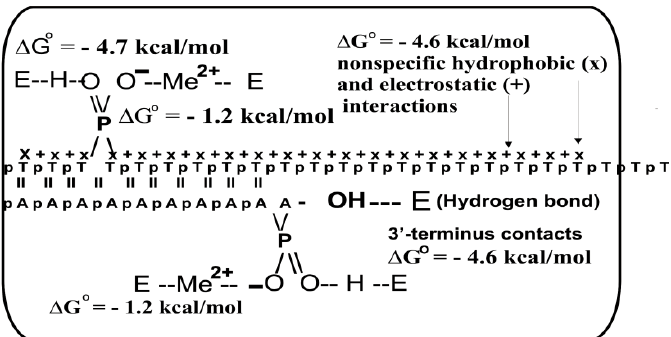
Figure 2. A thermodynamic model for the interaction of human DNA polymerase α with d(pT) 20 × d(pA) 10 [20,21]. It can be seen that the globule of DNA polymerase covers 20 nucleotide units of the template and 10 nucleotides of complementary primer. Bases of the template and 19 out of 20 internucleoside groups form weak additive contacts with the template-binding site of the enzyme (total ΔG° = −4.6 kcal/mol), while one internucleoside phosphate group of the template has strong contacts—one hydrogen bond and one electrostatic contact (total ΔG° = −4.7 kcal/mol). Only the 3′- terminal unit of the primer makes contacts with the enzyme, forming ONE hydrogen bond WITH THE 3′-OH primer group and two contacts WITH THE FIRST from the 3′-end internucleoside phosphate group (total ∆ G ◦ = − 4.6 kcal/mol). The rest of the primer nucleotide units interact only with the complementary template through the formation of Watson–Crick hydrogen